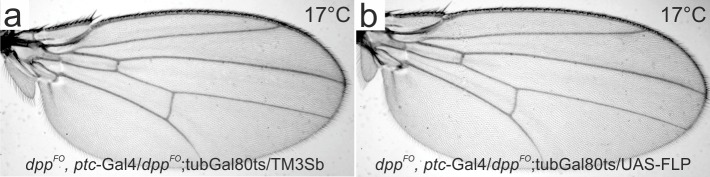
A control experiment under permissive temperature (17°C) for Figure 3.(a) A control male wing of dppFO, ptc-Gal4/dppFO; tub-Gal80ts/TM3Sb. (b) a male wing of dppFO, ptc-Gal4/dppFO; tub-Gal80ts/UAS-FLP.